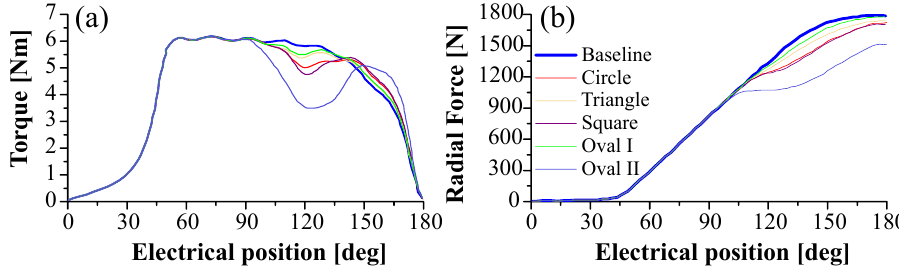
Figure 19. Various rotor window geometries: ( a ) Square, ( b ) Triangle, ( c ) Circle, ( d ) Oval I, and ( e ) Oval II.